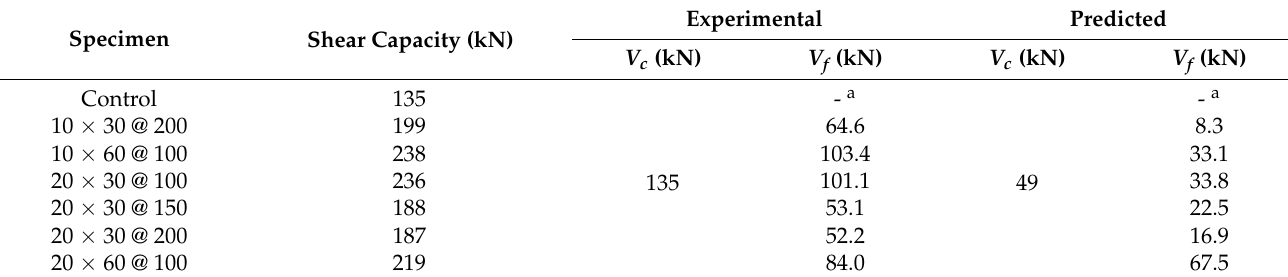
Table 4. Shear capacity contribution.